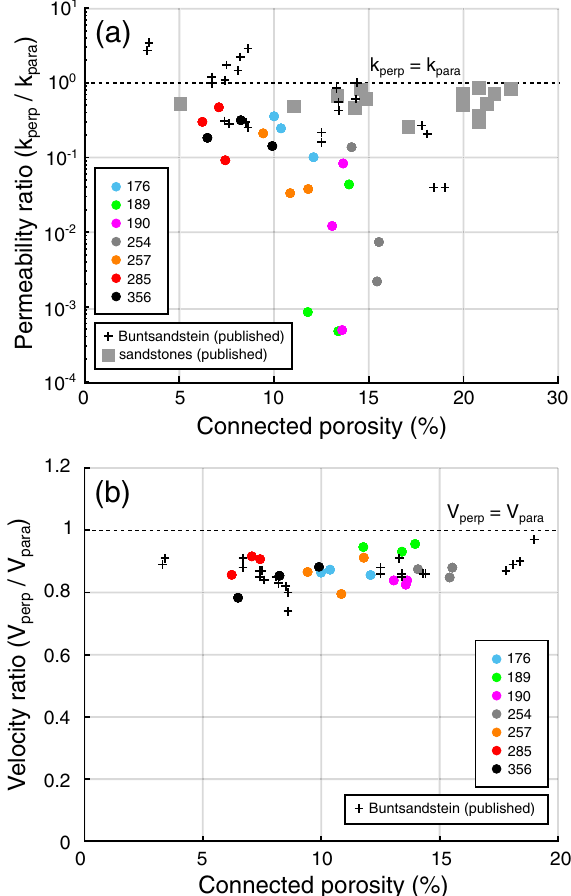
Fig. 12 a Permeability ratio and b P-wave velocity ratio as a function of connected porosity for the Buntsandstein sandstone samples prepared for this study, together with previously published data for Buntsandstein sandstone samples taken from EPS-1 (Soultz-sous-Forêts) (black crosses; data from Griffiths et al. 2016; Heap et al. 2017) and other sandstones (grey squares; data from Benson et al. 2005; Clavaud et al. 2008; Baud et al. 2012; Meng et al. 2021). The number refers to the box